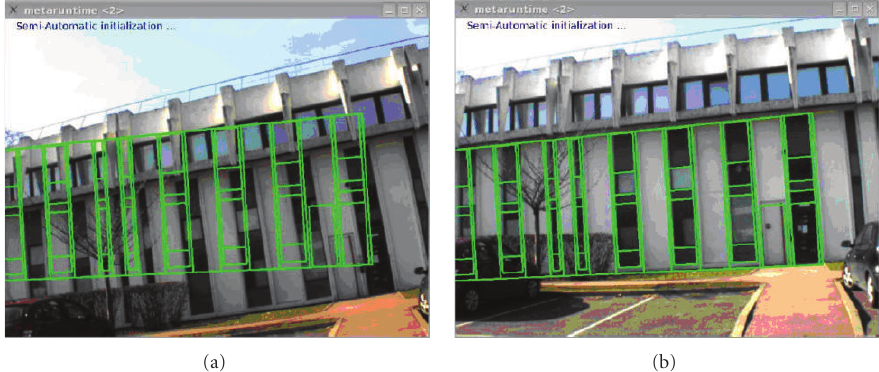
Figure 3: (a) the model environment rendering. (b) manual alignment between the projected model and its image.